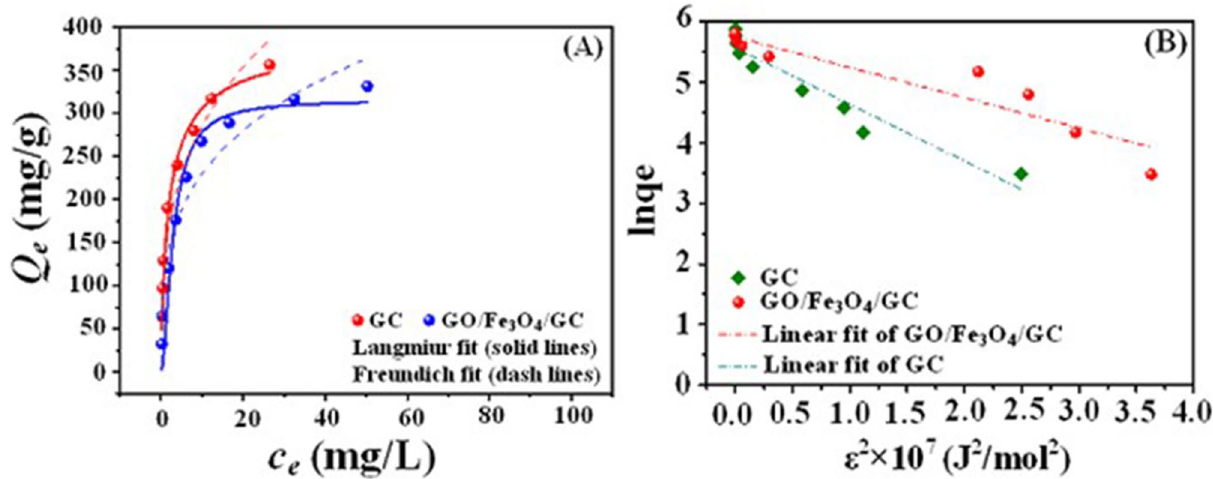
Figure 6. The fit results of Langmuir and Freundlich ( A ) and D–R ( B ) isotherm models for GC and GO/Fe 3 O 4 / GC. pH = 5.0 and 6.0, C